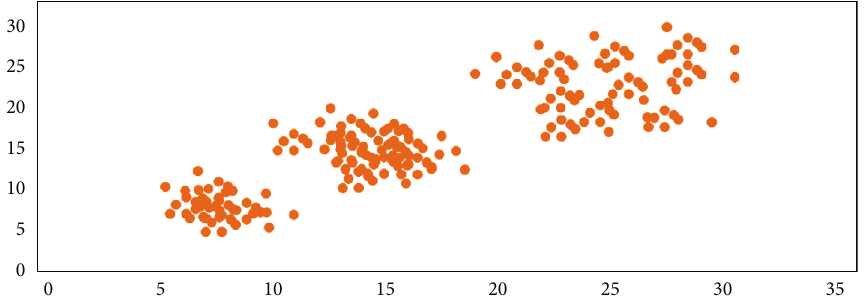
Figure 6: Clustering results of teachers ’ teaching status after removing outliers in a semester in Y